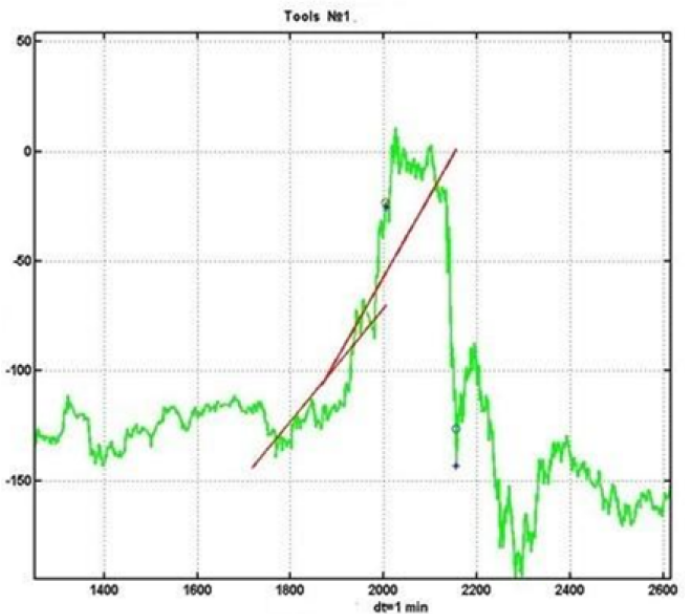
Figure 5. Examples of incorrect conclusions about the presence of a trend associated with a delay in